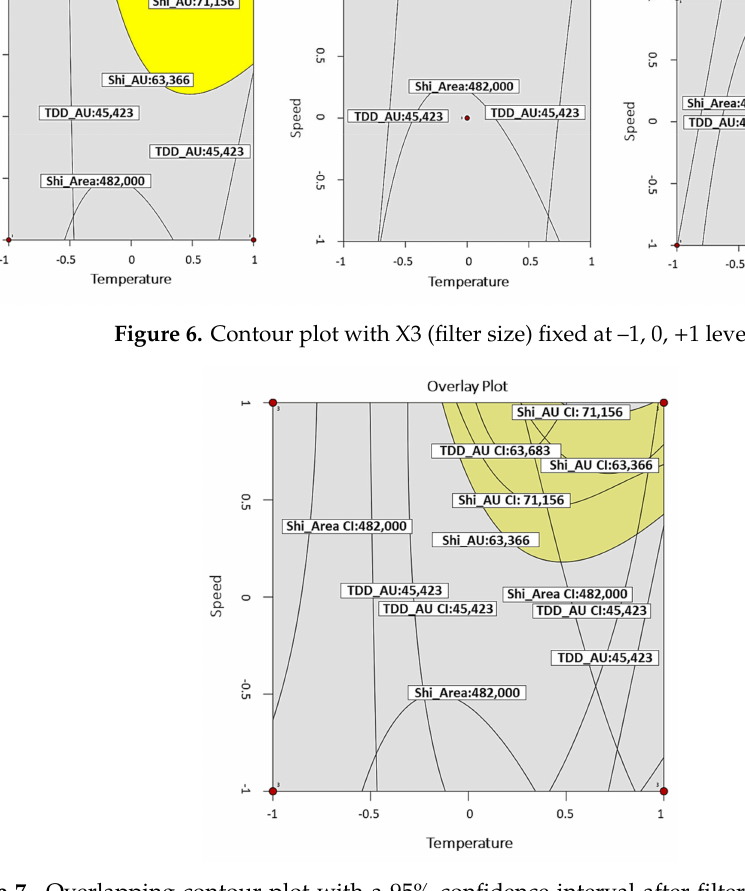
Figure 7. Overlapping contour plot with a 95% confidence interval after filter paper size (X3) − 1 level